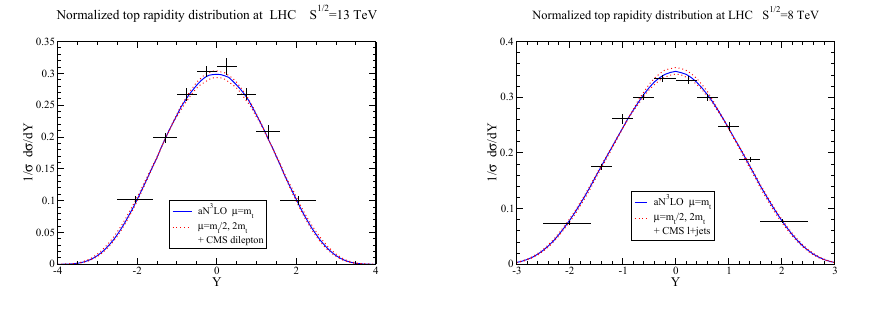
Figure 6. Top-quark aN 3 LO normalized rapidity distribution at (left) 13 TeV energy compared with CMS data [50] and (right) 8 TeV energy compared with CMS data